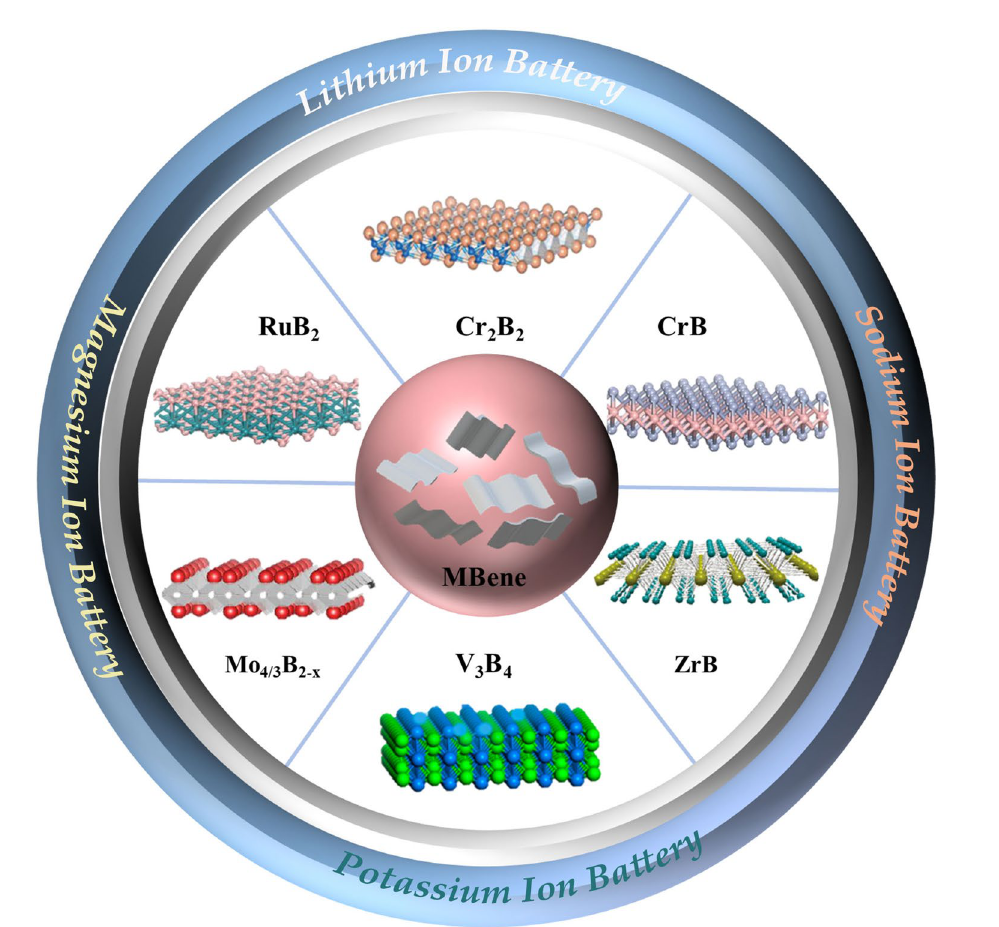
Fig. 3 Schematic diagram illustrating the structure of MBene along with energy storage applications. Reproduced with permission from Refs. [83,